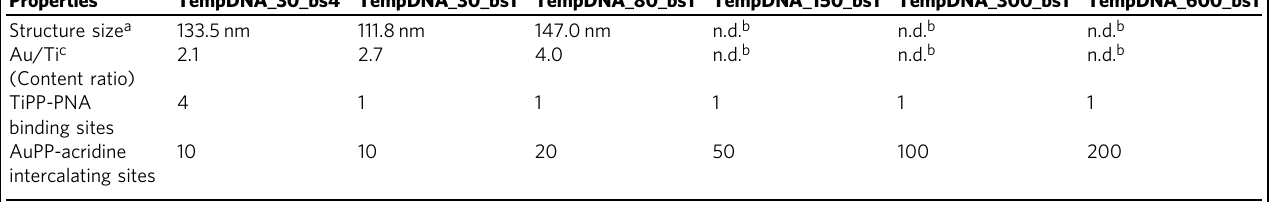
a Structure sizes are measured by DLS. b Gold with bulk size was formed, and it was impossible to fabricate the gold-titania nanocomposite. c The content ratio were measured by ICP-AES.